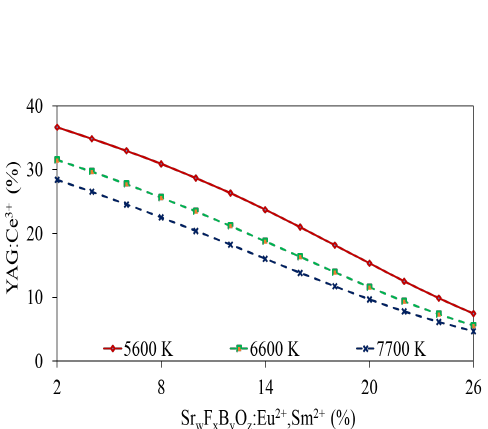
Fig. 2: The change of phosphor concentration for keep- ing the average CCTs.